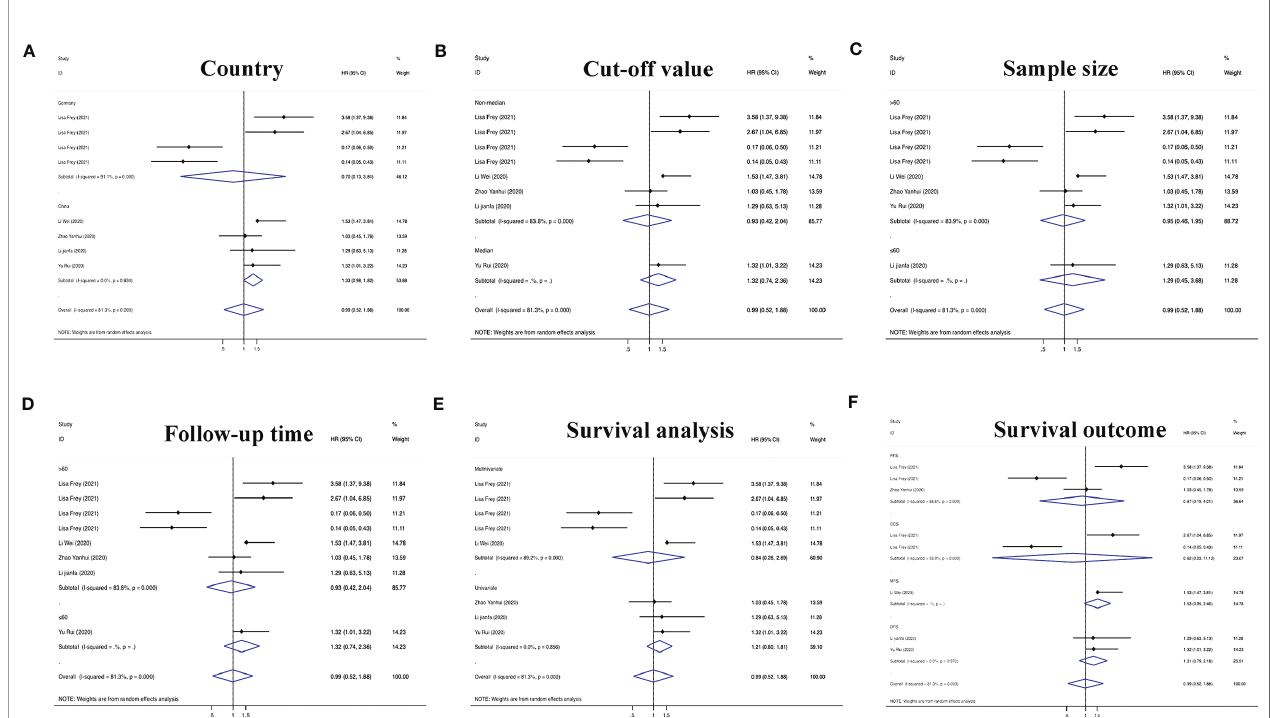
FIGURE 6 | Subgroup analyses of PFS/CCS/MFS/DFS for circRNAs, strati fi ed by (A) country, (B) cut-off value, (C) sample size, (D) follow-up time, (E) survival analysis, and (F) survival outcome.